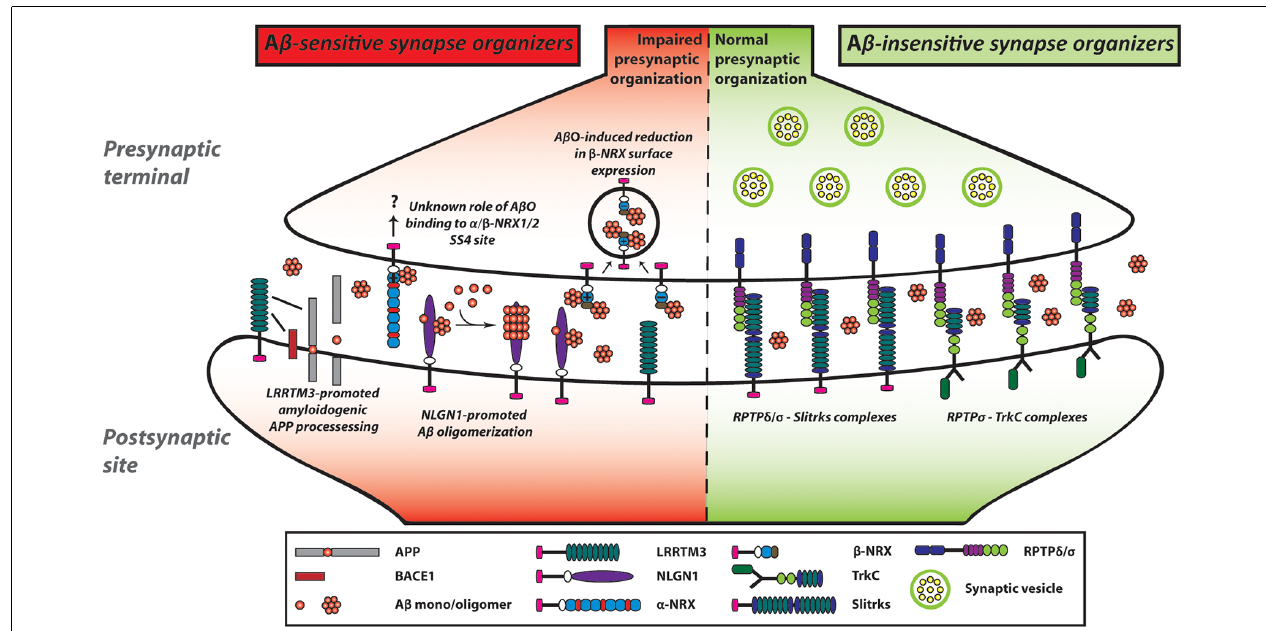
FIGURE 3 | NRX-based and LAR-RPTP-based synaptic organizing complexes display contrasting A β sensitivity. A β Os exert a pathological influence on NRX-based synaptic organizing complexes. In contrast, LAR-RPTPs and their post-synaptic binding partners appear to be resistant to A β O-induced deleterious effects on synapses. A β Os bind to the HRD of β -NRXs as well as to the SS4 of NRX1/2. Furthermore, A β Os reduce the expression of β -NRXs on axon surface in an HRD-dependent but SS4-independent manner. However, the role of the NRX SS4 in A β synaptic pathology remains to be understood. In addition to NRXs, NLGN1 can interact with A β and act as an A β deposition stabilizer to accelerate A β oligomer formation and fibrillar aggregation. Although A β Os affect not only NRXs but also LRRTMs and NLGNs, we propose that A β O-mediated β -NRX surface reduction may account the most in A β -impaired synapse organization. As an additional role of LRRTMs in the A β pathway, LRRTM3 interacts with amyloid precursor protein (APP) as well as β -site APP cleaving enzyme 1 (BACE1) and promotes amyloidogenic APP processing to enhance A β production. Thus, NRXs and their partners are highly linked with A β pathology, which may result in A β vulnerability of synapses in Alzheimer’s disease (AD). In contrast, A β Os do not interact with LAR-RPTPs or their postsynaptic partners including TrkC and Slitrks. Accordingly, LAR-RPTP-based complexes may contribute to making synapses more tolerant of A β pathology in AD. Solid lines indicate protein